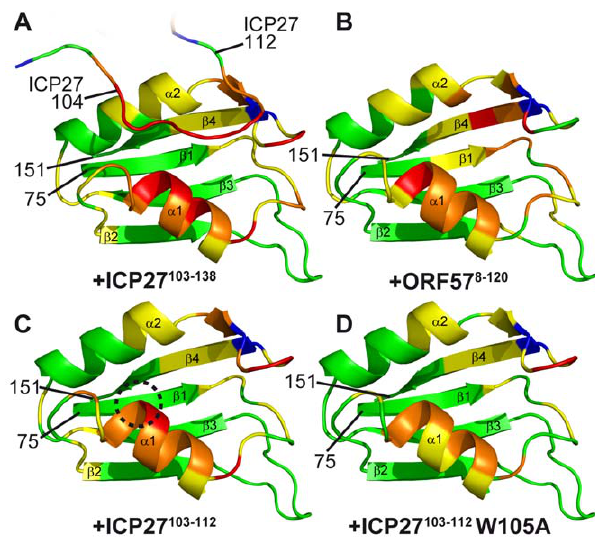
Figure 3. Mapping of the ICP27- and ORF57-induced signal shifts onto the structure of REF RRM domain. Backbone amide weighted chemical shift changes ( d CS) are emphasized by colour. d CS . 0.3 are red, 0.15–0.299 orange, 0.05–0.149 yellow, prolines are blue and regions unaffected are green. ( A ) Regions affected by addition of ICP27 103–138 . True ICP27 chain position determined based on NOE data is also shown for reference, with corresponded chemical shift changes due to REF binding similarly mapped. ( B ) Similar regions are affected by ORF57 8–120 and ( C ) synthetic peptide ICP27 103–103 . ( D ) Synthetic mutant peptide ICP27 103–103 W105A binding affects the same RRM regions, however the value of shifts at the top of a -helix 1 is reduced, highlighting the binding site for W105 (encircled on panel C ). The position and numbering of N- and C- terminal residues are indicated.